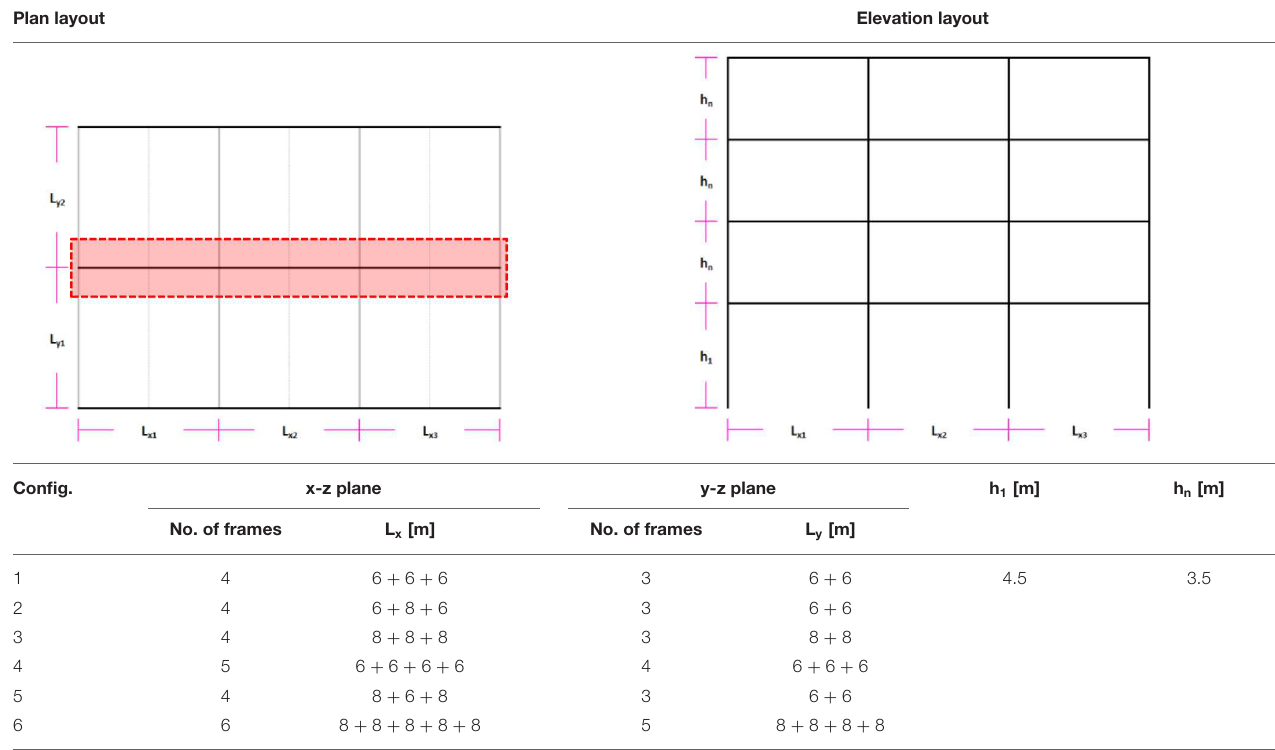
TABLE 1 | Building configurations and geometrical properties (Macedo et al., 2019). Plan